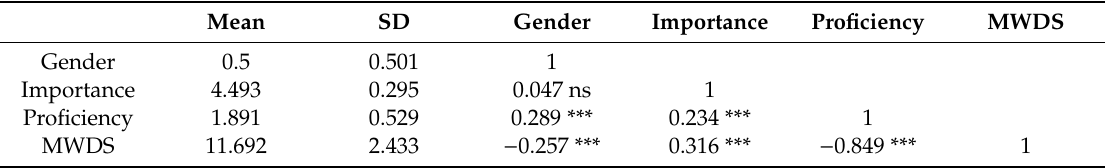
Table 2. Point-biserial correlation ( S =